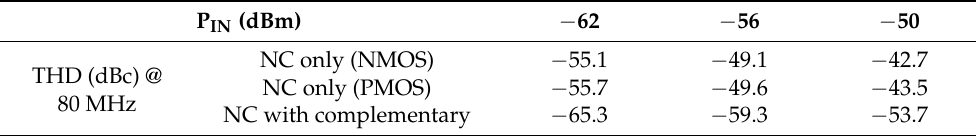
Figure 13. Simulated input-referred voltage noise density of the proposed LNA. Table 1. Simulated THD of the LNA.